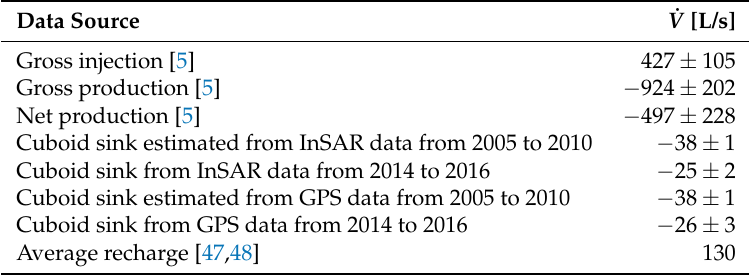
Table 6. Estimates of subsurface volume change from multiple data